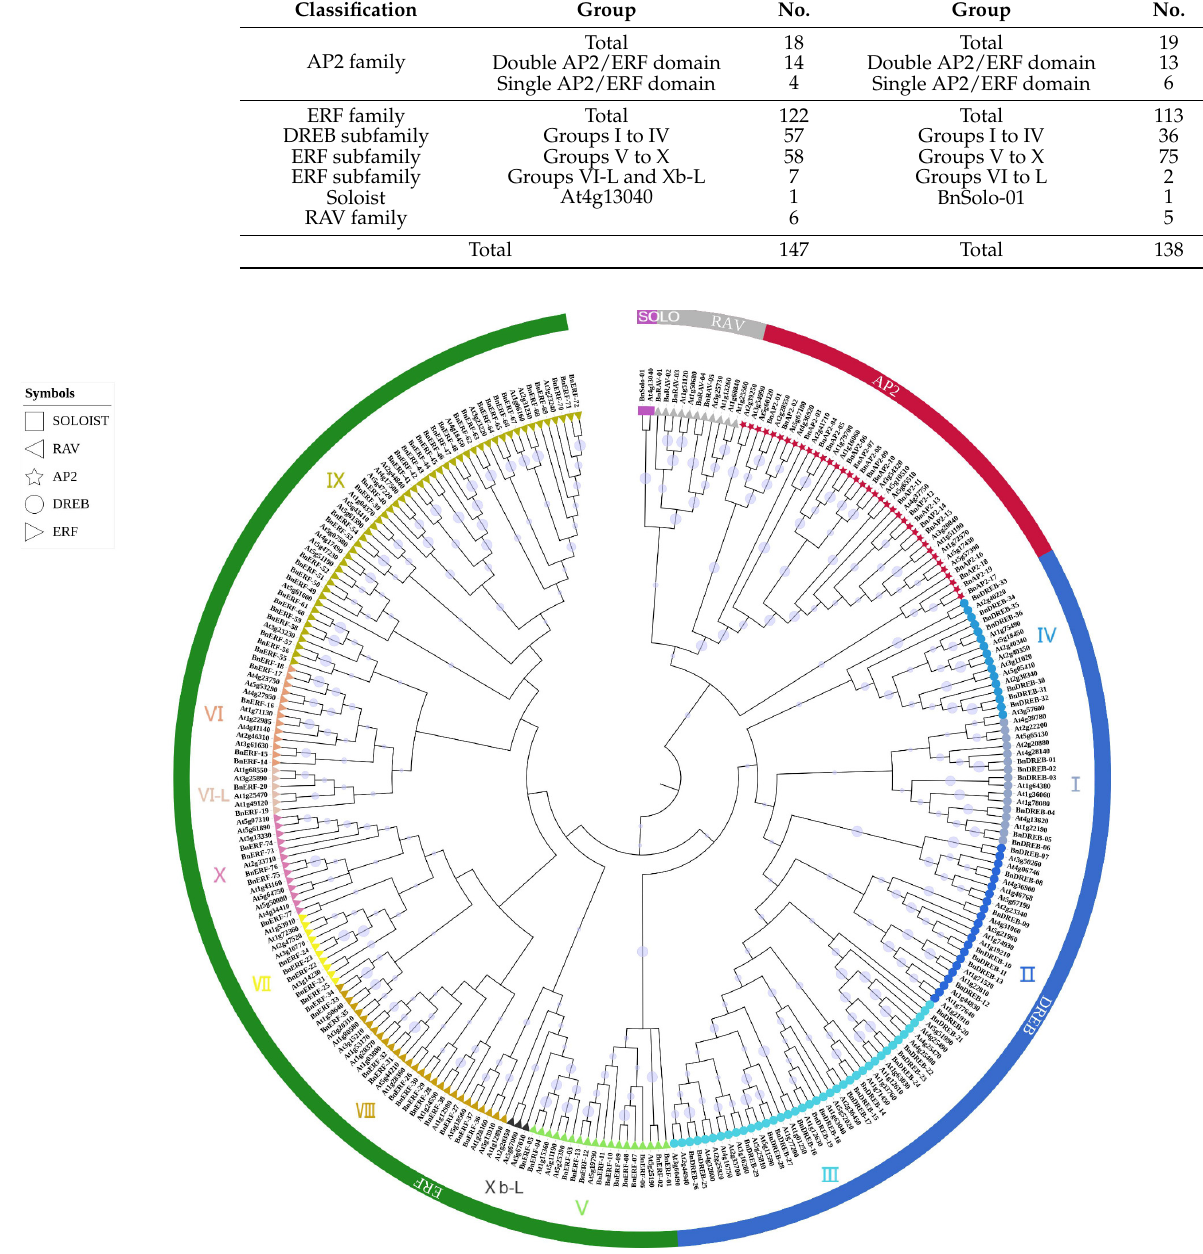
Table 1. The profile and comparison of AP2/ERF superfamily TF genes between ramie and Ara- bidopsis .